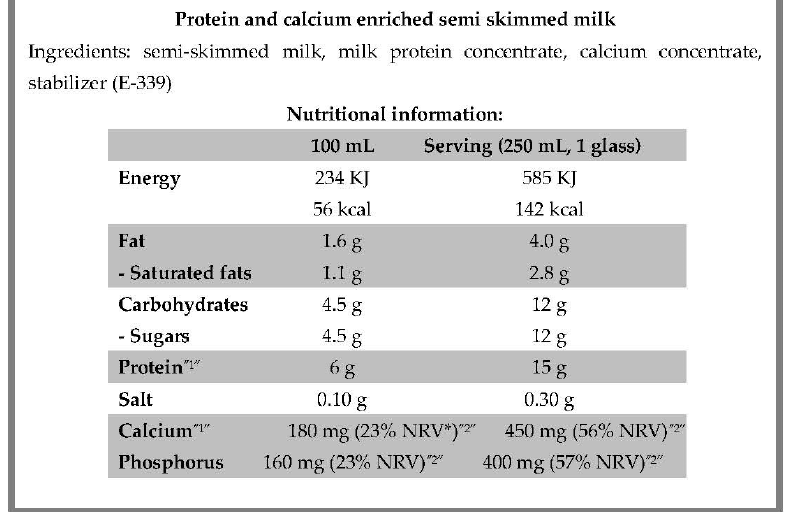
Figure 2. An example of the back of a fortified food label. Adapted from a commercial product. * nutrient reference values (NRVs). According to the European legislative framework, the mandatory stances: 1 The amounts of protein (6 and 15 g per 100 g and serving) and calcium (180 mg and 450 mg